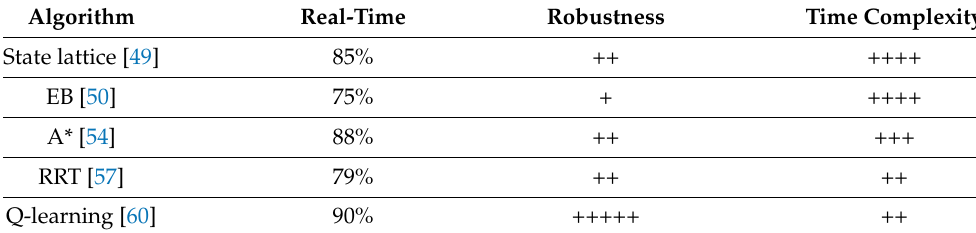
Table 6. Algorithms performance of trajectory